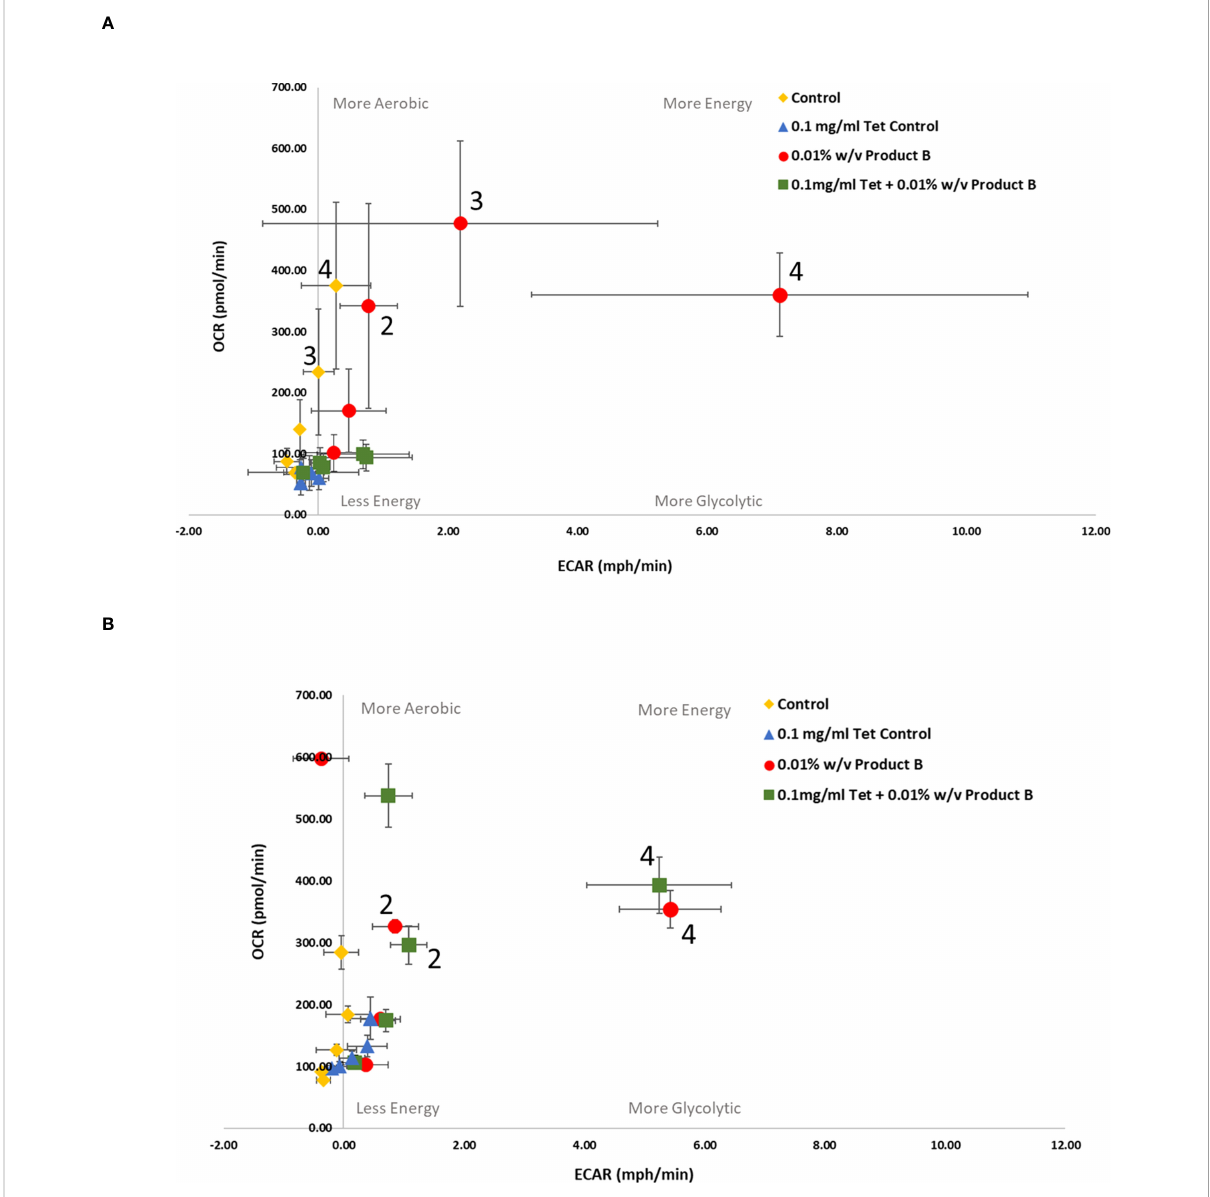
FIGURE 3 Bioenergetic real time changes in OCR/ECAR ratio of (A) antibiotic susceptible E. coli and (B) antibiotic resistant E. coli when treated with YPPB. Numbered data points represent the following time-points (0) 14 mins (1) 52 mins (2) 98 mins (3) 149 mins (4) 201 mins. Several data points have been labelled with their representative time-points for ease of results visibility. Each value was expressed using mean of triplicates for each biological replicate (n=3), error bars are representative of standard deviation. Control refers to no product/tetracycline supplementation. Product B =